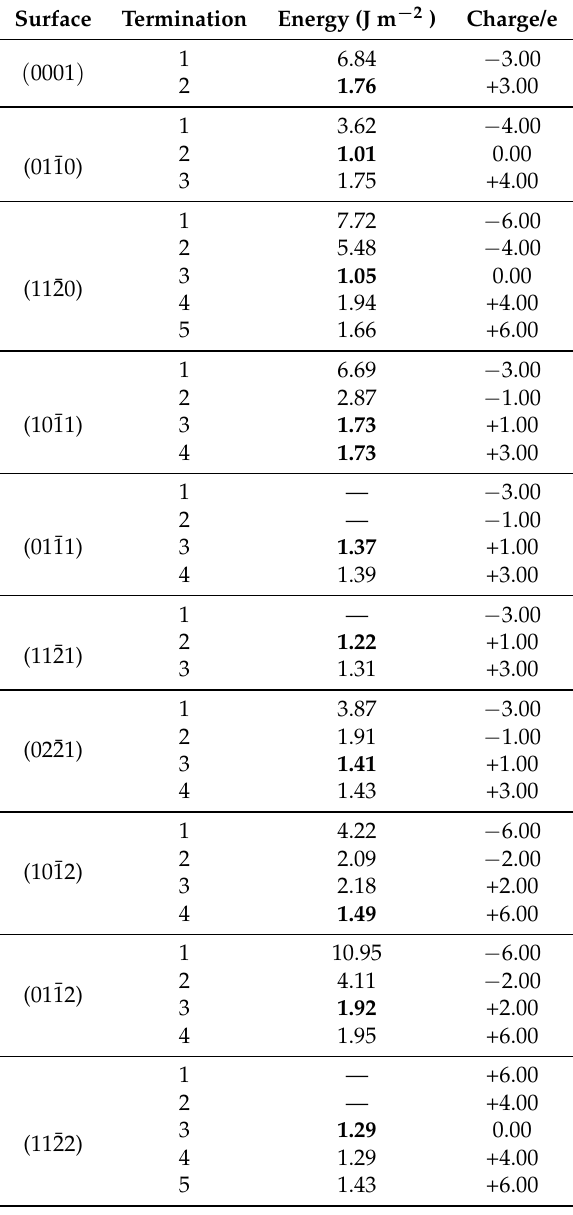
Table 1. The calculated (PBE-D3 (BJ)) surface energies and the net charge of each of the possible terminations of the various surfaces. The most stable surfaces are highlighted in